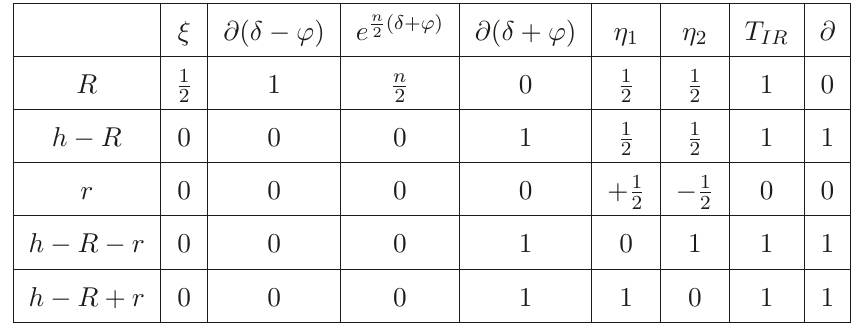
Table 3 . Summary of the R -weights assigned to the free fields and C 2 -cofinite